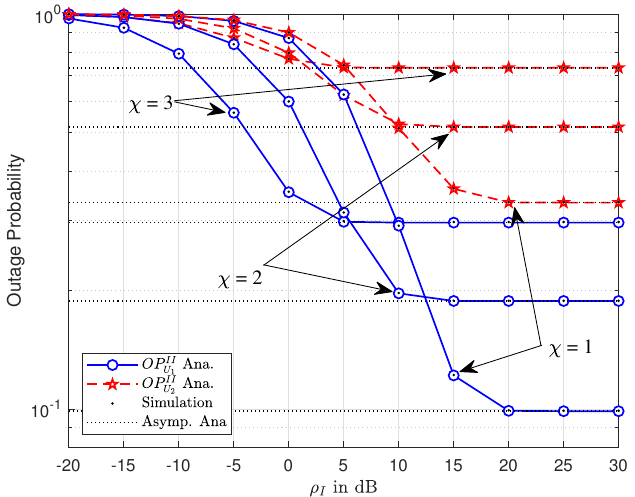
Figure 5. Outage performance of U 1 and U 2 versus ρ I with varying χ